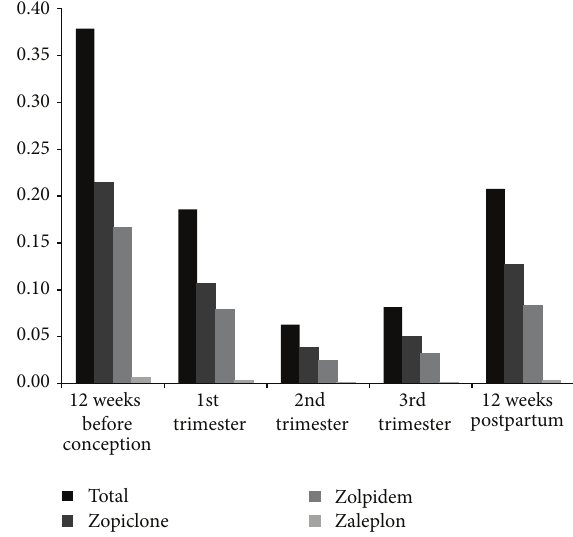
Figure 2: Exposure to hypnotic benzodiazepine receptor agonist during pregnancy (% of all pregnancies). Drugs are divided into subgroups of the different HBRAs available in